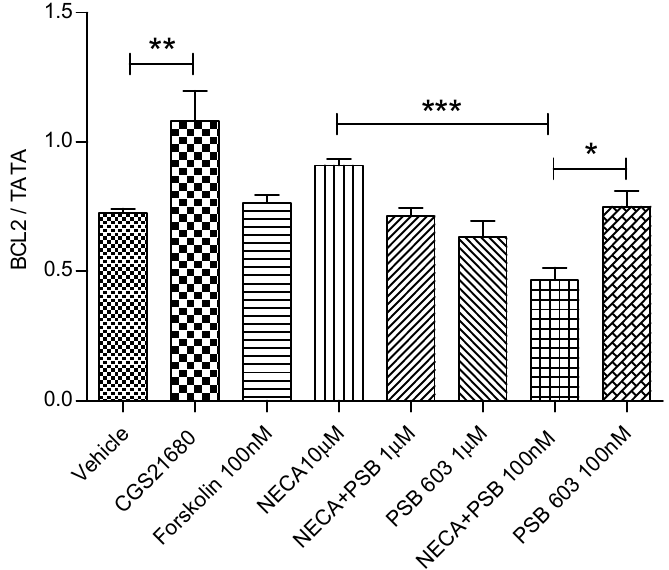
Figure 3. Effects of NECA, CGS21680, and PSB 603 on the gene expression of BCL2 messenger RNA (mRNA) in rat L6 skeletal muscle myotubes using charcoal serum. * denotes p < 0.05, ** denotes p < 0.01 and *** denotes p < 0.001. Data were analyzed with a one-way ANOVA test, then a Tukey test.